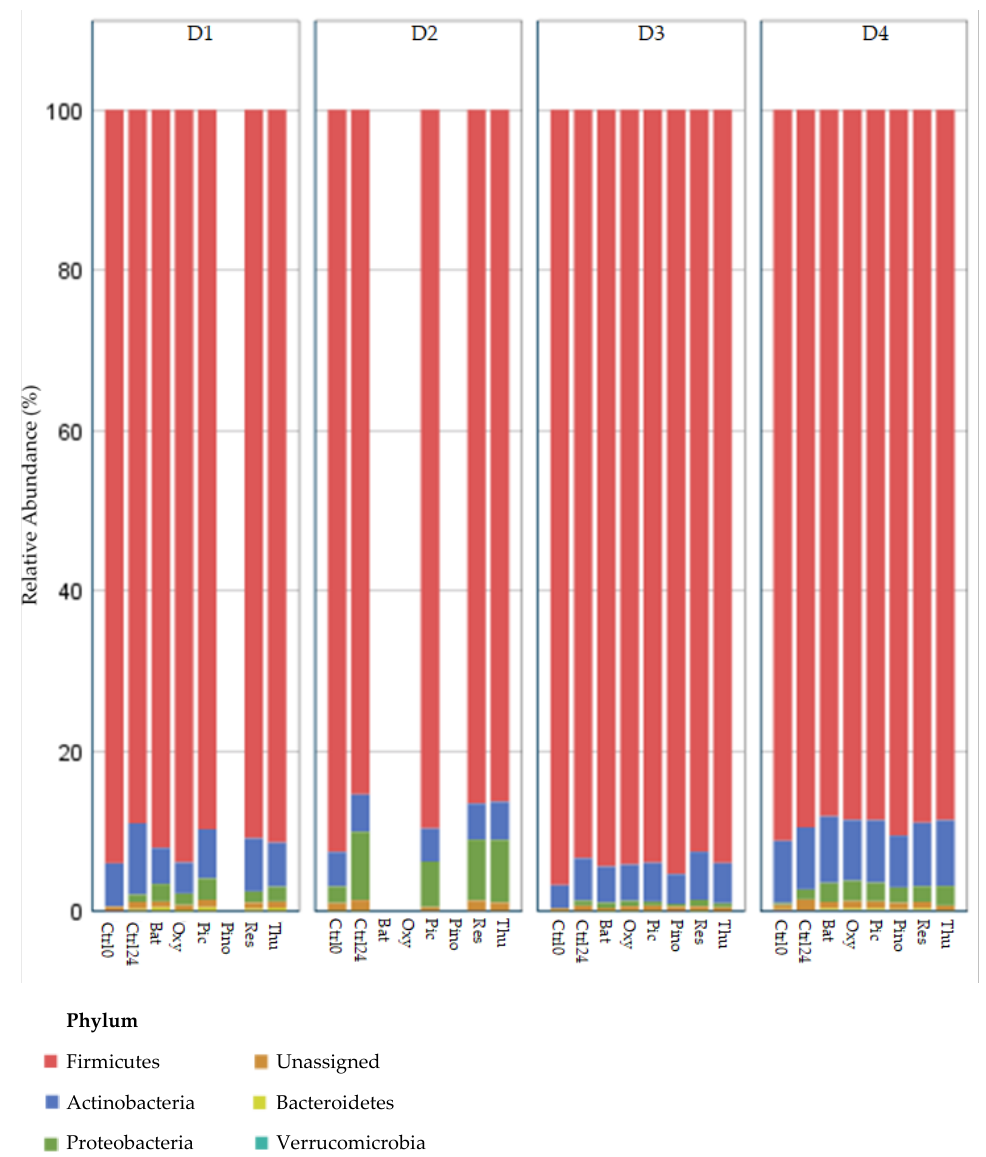
Figure A1. Bacterial composition at the phylum level, per donor. D# denotes the donor; Ctrl0, control at 0 h; Ctrl24, control at 24 h; Bat, batatasin III; Oxy, oxyresveratrol; Pic, piceatannol; Pino, pinostilbene; Res, trans-resveratrol; Thu, thunalbene (all stilbenoids at 24 h).